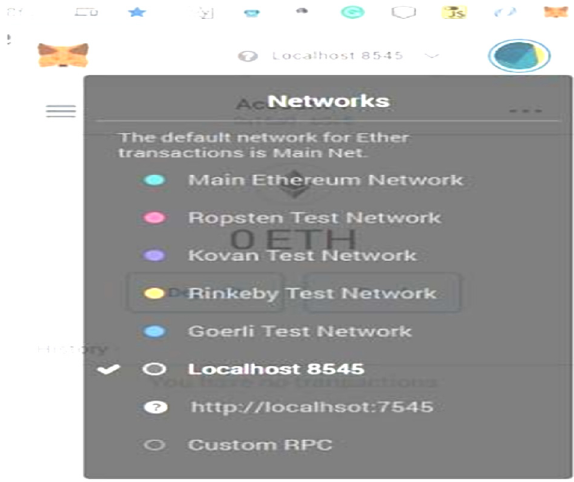
Figure 10. MetaMask framework.